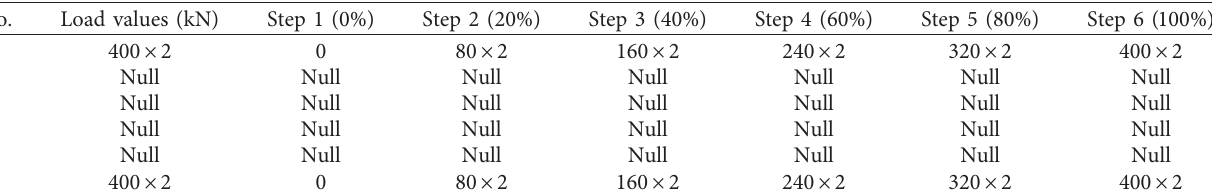
Figure 11: Arrangement of loading devices on the segment model. Table 2: Multipoint loading scheme and loading values.